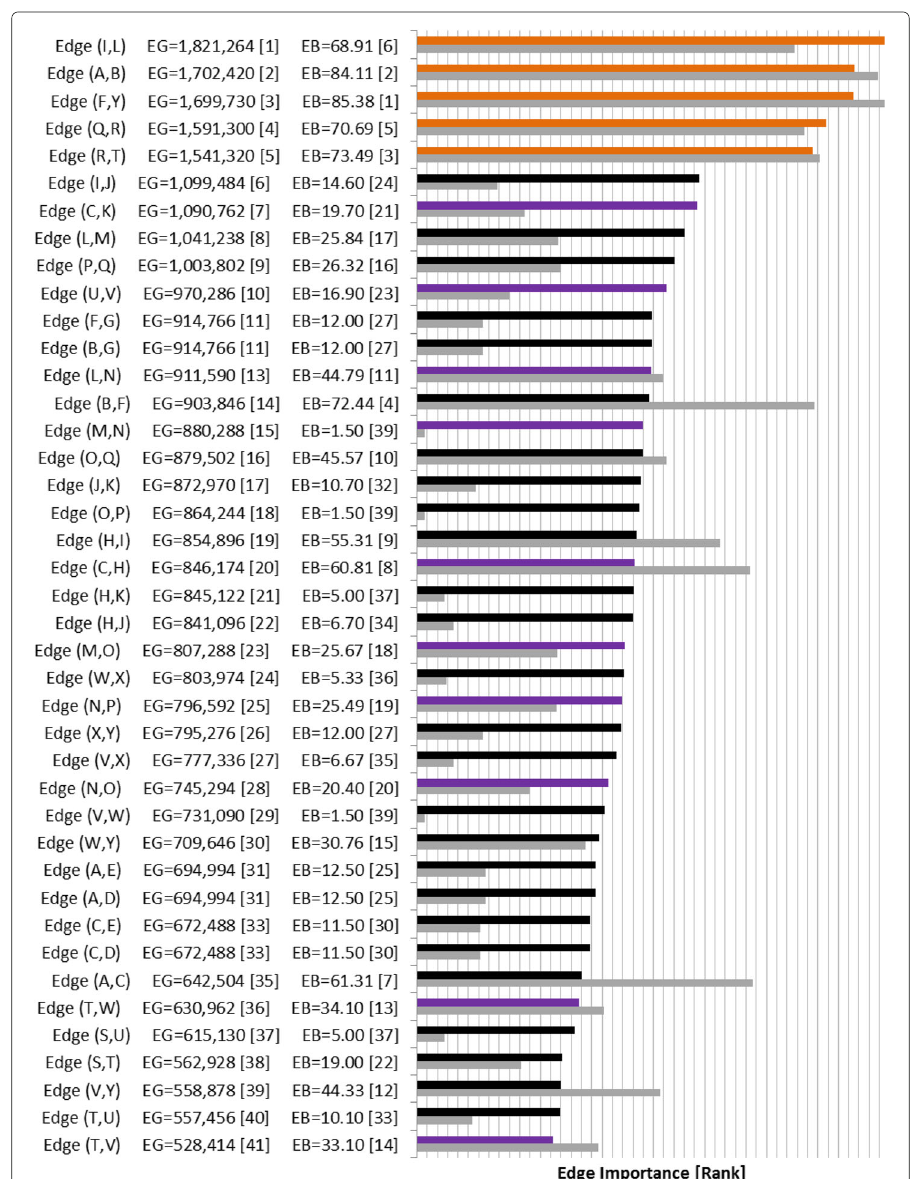
Fig. 11 Edge Gravity (EG) and Edge Betweenness (EB) solutions for Granovetter’s Example B